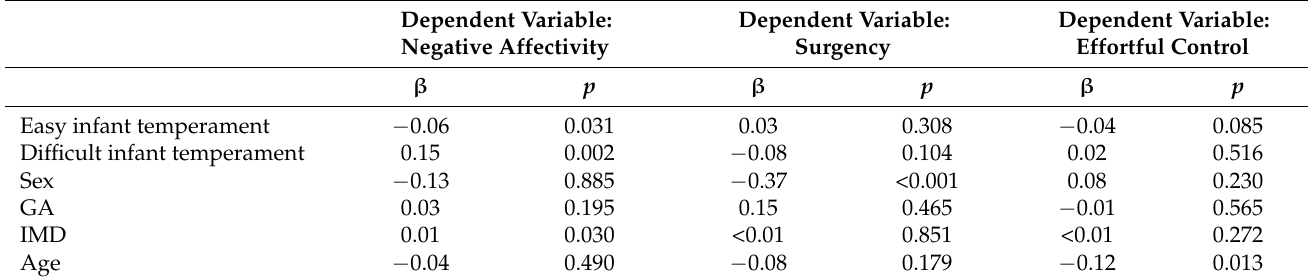
Table 3. Results of univariate follow-up analyses separately regressing Negative Affectivity, Surgency or Effortful Control on infant temperament (easy and difficult), controlling for age, sex, gestational age (GA) and index of multiple deprivation (IMD). A Bonferroni-corrected significance threshold of p = 0.017 was